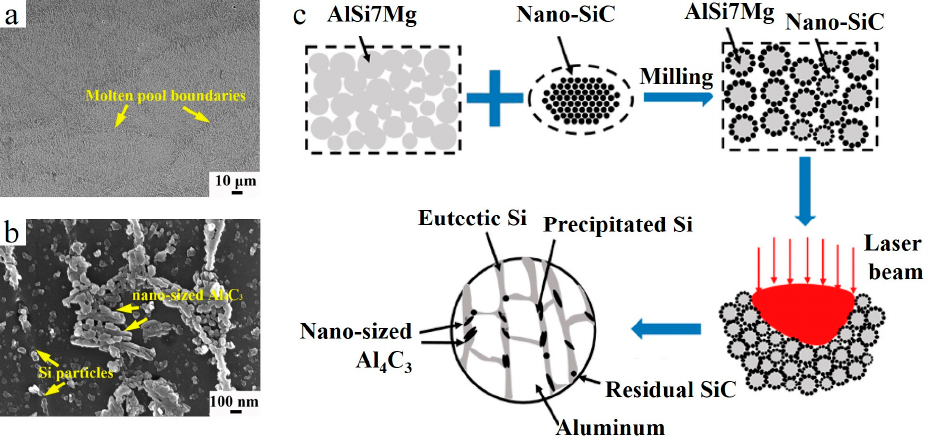
Figure 15. Cross section SEM images of the LPBF-ed AlSi7Mg/2 wt.% nano-SiC composite ( a , b ) and the illustration of the formation route of different phases during the LPBF process ( c ) (reproduced with permission from [8]).